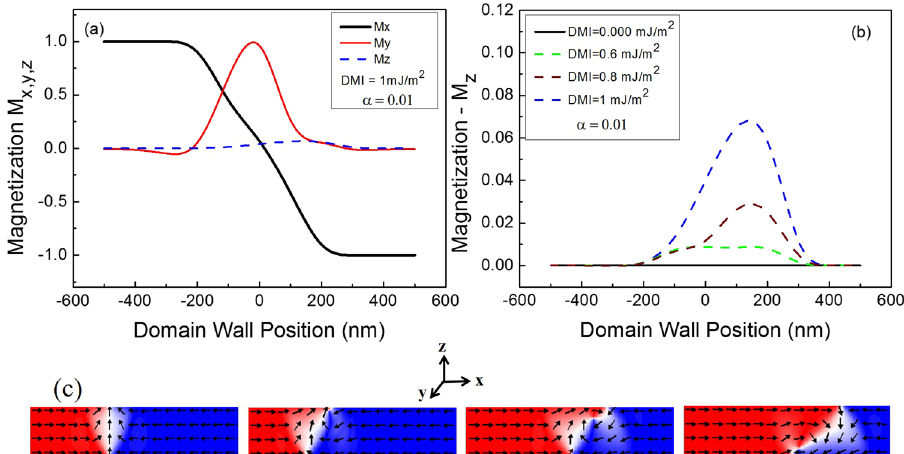
Figure 7. Magnetization component calculated along of the DW position in the nucleation process for damping equal 0.01. In ( a ), the M x magnetization component varies from 1 to − 1 due the magnetic moments head to head around the DW. The M y magnetization component has a positive value as expected for transverse domain wall up. Interestingly, the M z component, see dashed blue line, emerges for a DMI value of 1 mJ/m 2 . In ( b ) these magnetization components were calculated for different values of DMI and it is shown that the M z magnetization component increases as the DMI becomes larger. The continuous line shows the absence of M z magnetization component without DMI. In ( c ), snapshots shows the transitions from transverse domain wall up to down mediated by core vortex